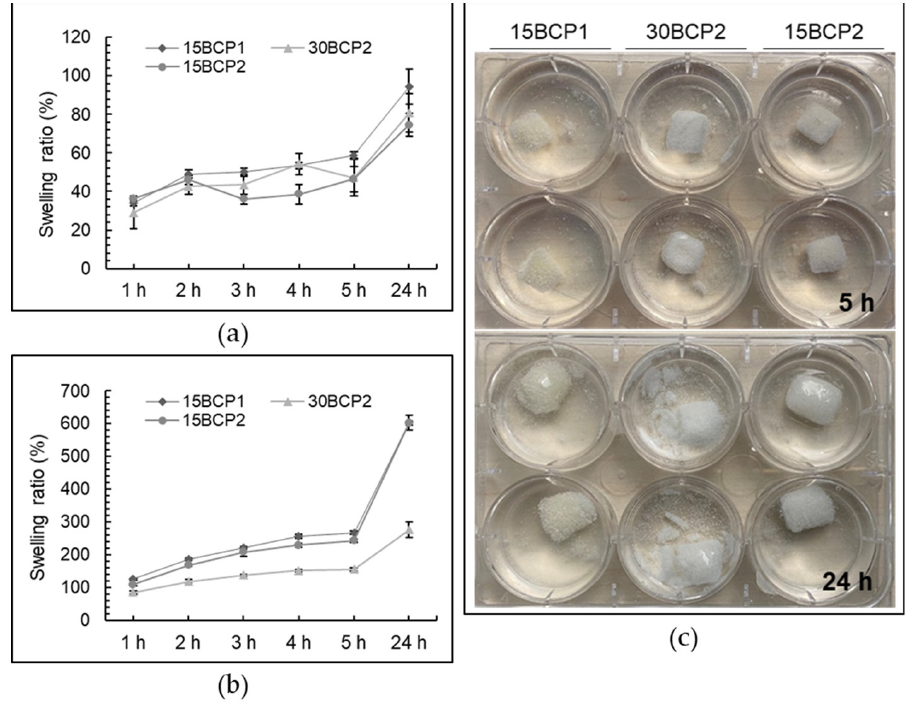
Figure 10. Swelling ratio (%) in DPBS as a function of incubation time of the ( a ) fresh and ( b ) dehydrated 3D-printed cubes fabricated from ceramic hydrogels of different compositions. ( c ) Optical images of the rehydrated structures after 5 h and 24 h. Table 2. Weight (W) and height (H) loss of dehydrated 3D-printed cubes.